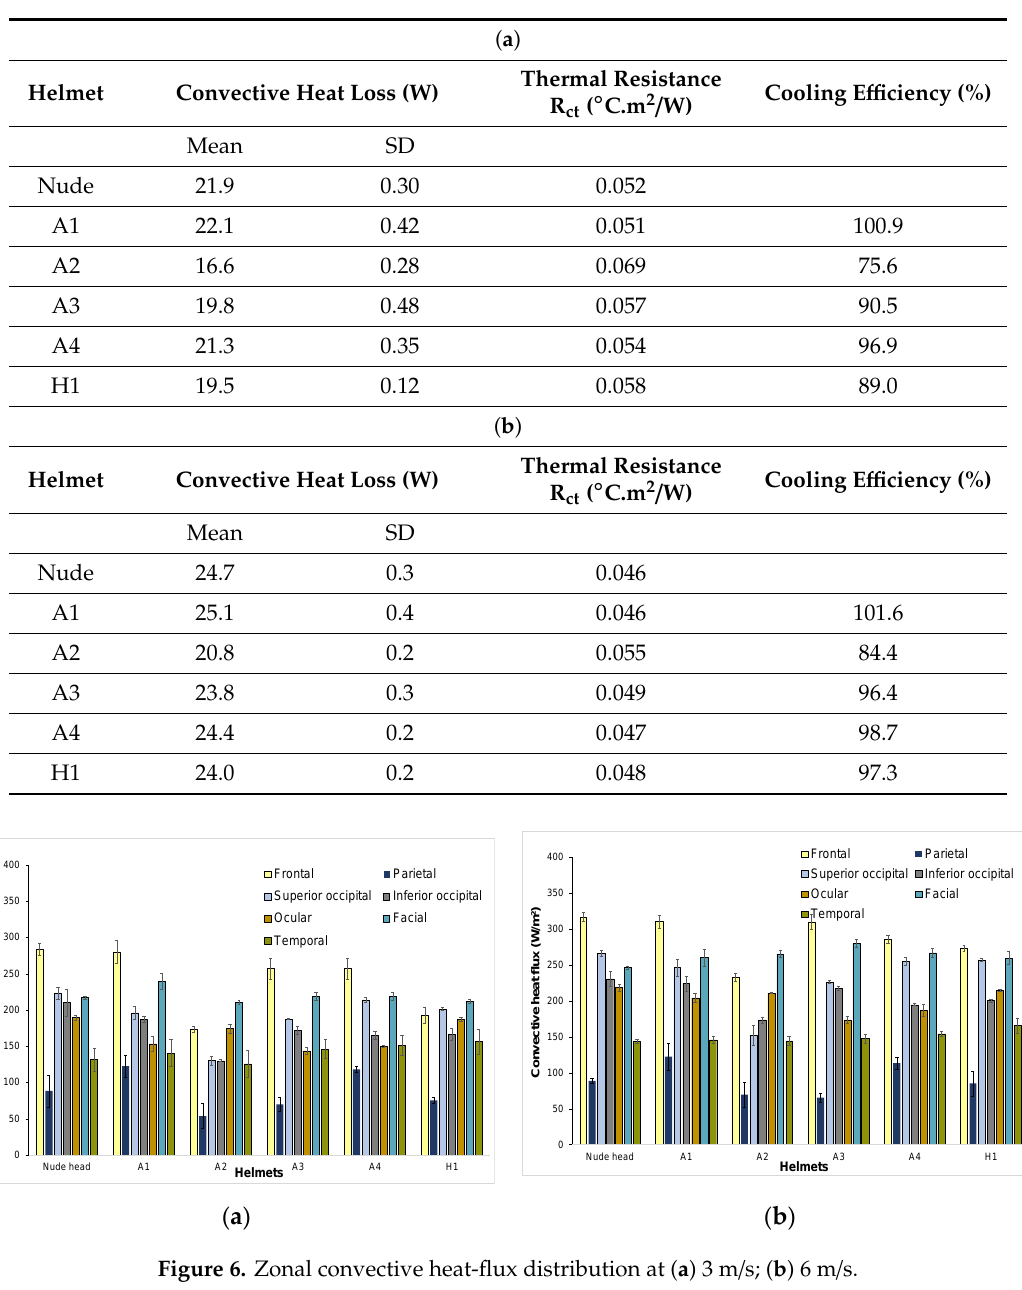
Table 3. ( a ) Convective heat-loss values at 3 m / s. ( b ) Convective heat-loss values at 6 m / s.